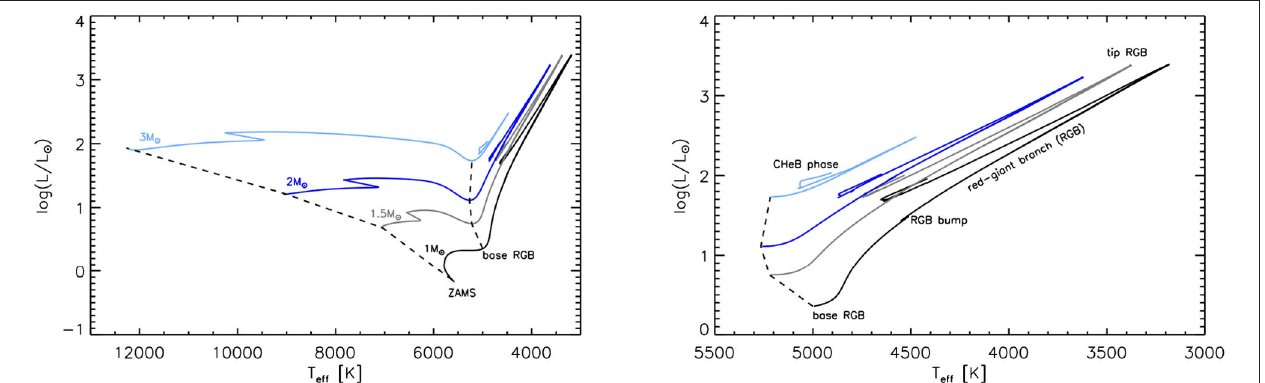
FIGURE 1 | Left : HR Diagram with four evolutionary tracks of models of masses 1.0, 1.5, 2.0 and 3.0 M are shown from the zero age main sequence (ZAMS) through the red-giant branch (RGB) and the core helium burning (CHeB) phase until the helium core mass fraction drops below 10 − 3 . Right : The same tracks as in the left panel now starting from the base of the red-giant branch. The models were computed using MESA (Paxton et al., 2019, and references therein) version r-10398 and solar metallicity. See Appendix A for the inlist of the MESA computations.